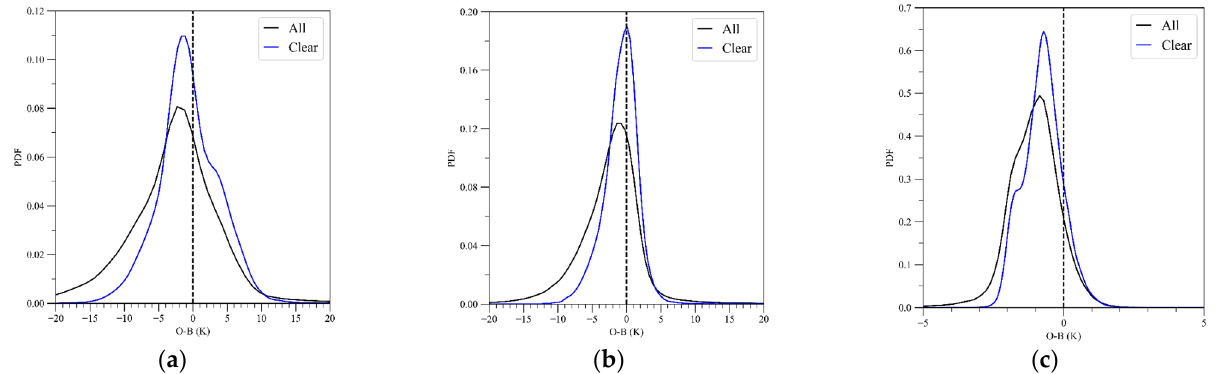
Figure 10. The O − B probability distribution curves for the original observations (black line) and after removal of cloudy observations (blue line) for AMSU-A ( a ) channel 1, ( b ) channel 3, and ( c ) channel 5 from NOAA-19 from June to August 2019. Table 2. The POD, FAR, and HR scores of three methods for cloudy sky and clear sky over the land area of East Asia from June to August 2019. In the statistics, the MODIS cloud product was used as a benchmark. AMSU-A and MHS MHS Old Mon Cloudy Clear HR %